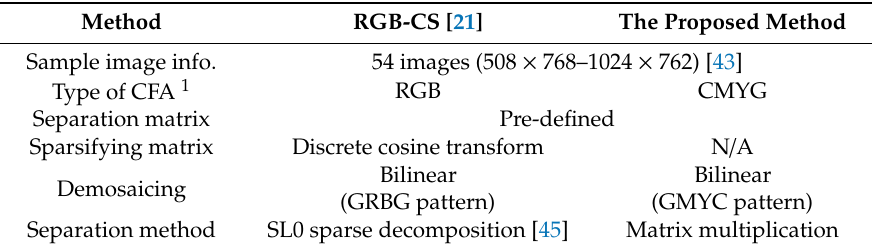
Table 1. The Simulation Conditions.